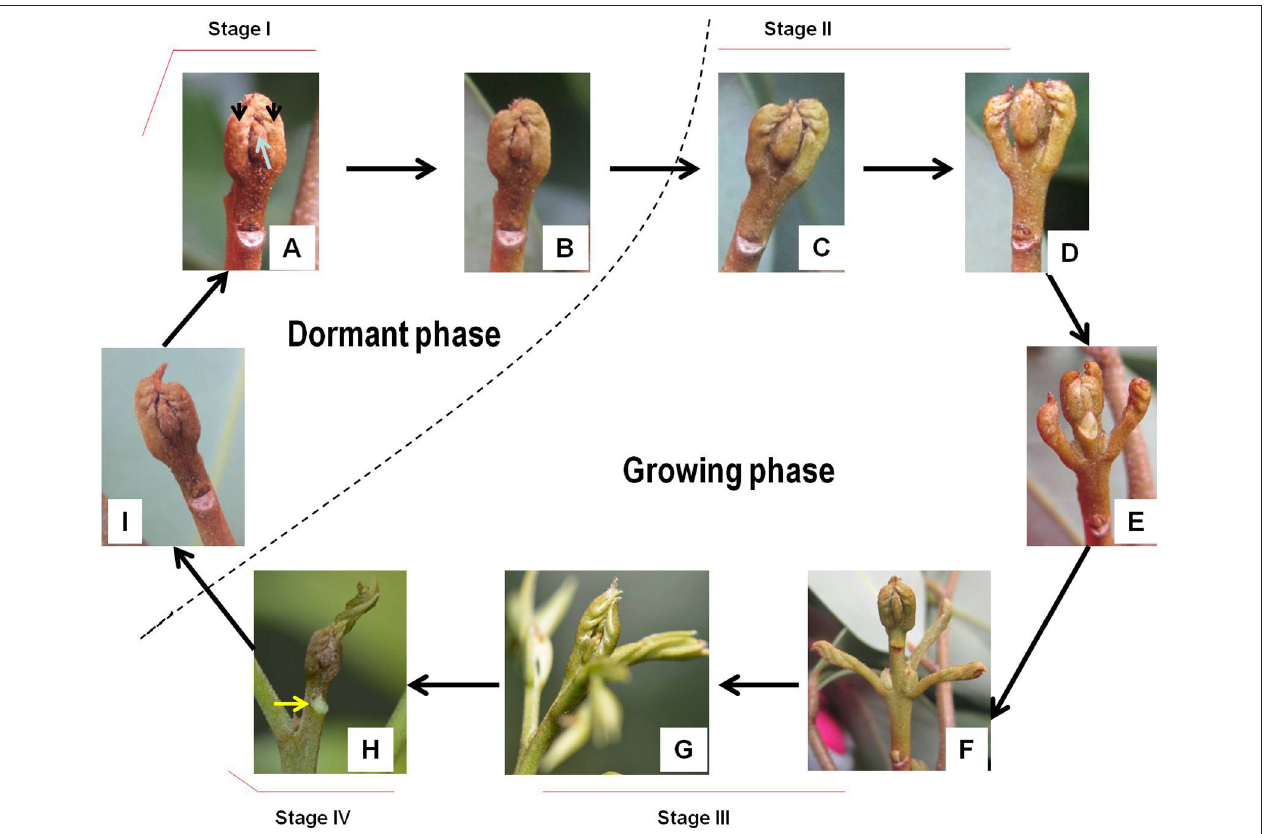
FIGURE 2 | Morphological changes of litchi bud during the development cycle (A–I). Dashed line separates the dormant phase and the growing phase. Arrows in subfigure (A) indicate rudimentary leaves or leaf primodia. The arrow in subfigure (H) denotes a freshly-formed leaf scar from an abscised leaf at the upper position of the new